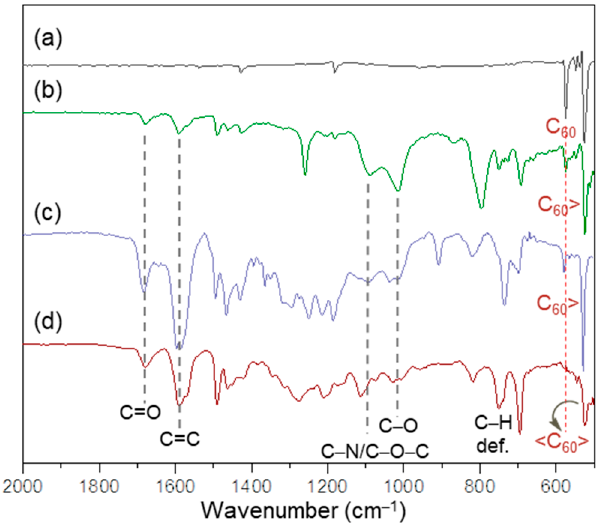
Figure 3. Infrared spectra (KBr) of (a) C 60 , (b) C 60 (>DPAF-C 9 ) ( 1 -C 9 ), (c) tris[C 60 (>DPAF-C 9 )]. and (d) tris[(DPAF-C 2M )-C 60 (>DPAF-C 9 )] ( 4 -C 2M − 9 ).